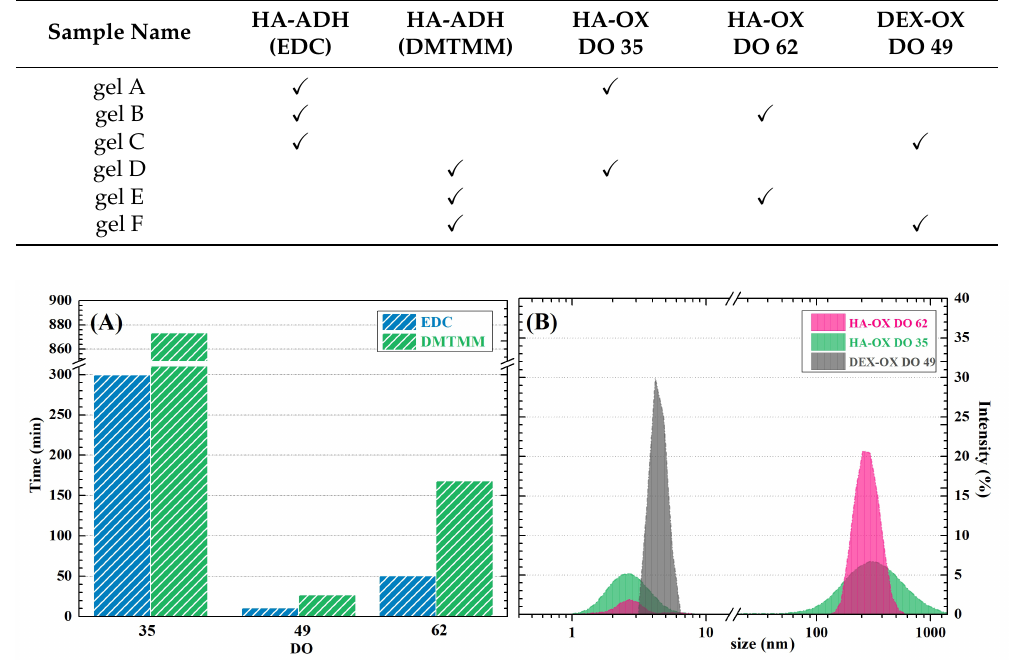
Figure 4. ( A ) Gelation times of HA gel formulations; ( B ) Hydrodynamic radius of oxidized polysac-